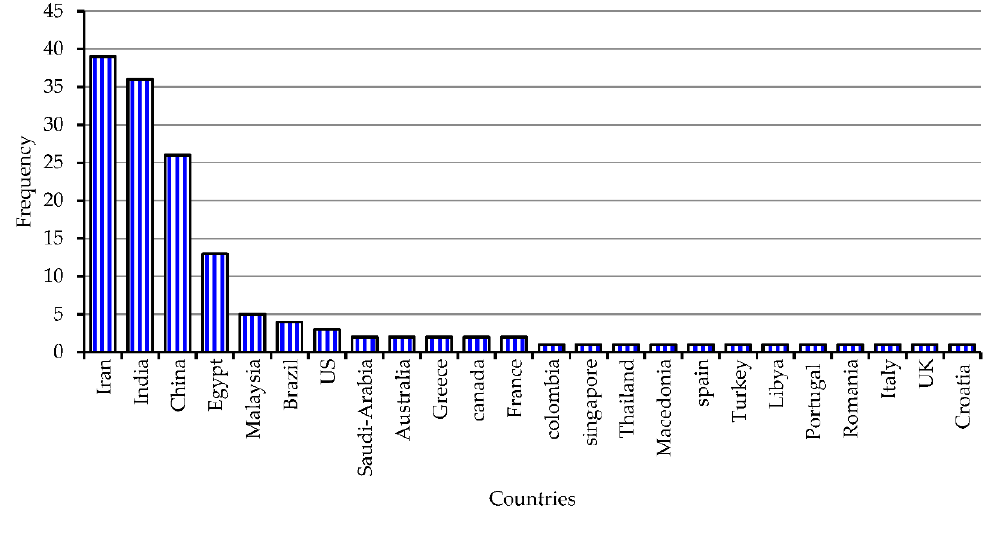
Figure 1. Summary of the literature works gathered from Table 1. ( i ) Objective function used for optimal multi-objective DG placement and sizing. ( ii ) Different optimizations used for optimal multi-objective DG placement and sizing. ( iii ) Types of DG used for optimal multi-objective DG placement and sizing problem. ( iv ) Dispatchable and real-time DG sources used for optimal multi-objective DG placement and sizing problem. ( v ) Different IEEE test systems used for optimal multi-objective DG placement and sizing problem. ( vi ) Different load models used for optimal multi-objective DG placement and sizing problem. ( vii ) Sizing/placement, or both, problems carried out for optimal multi-objective DG placement and sizing problem. ( viii ) Single large or multiple DGs used for optimal multi-objective DG placement and sizing problem. (ix ) Research for optimal multi-objective DG placement and sizing problem conducted in different countries.